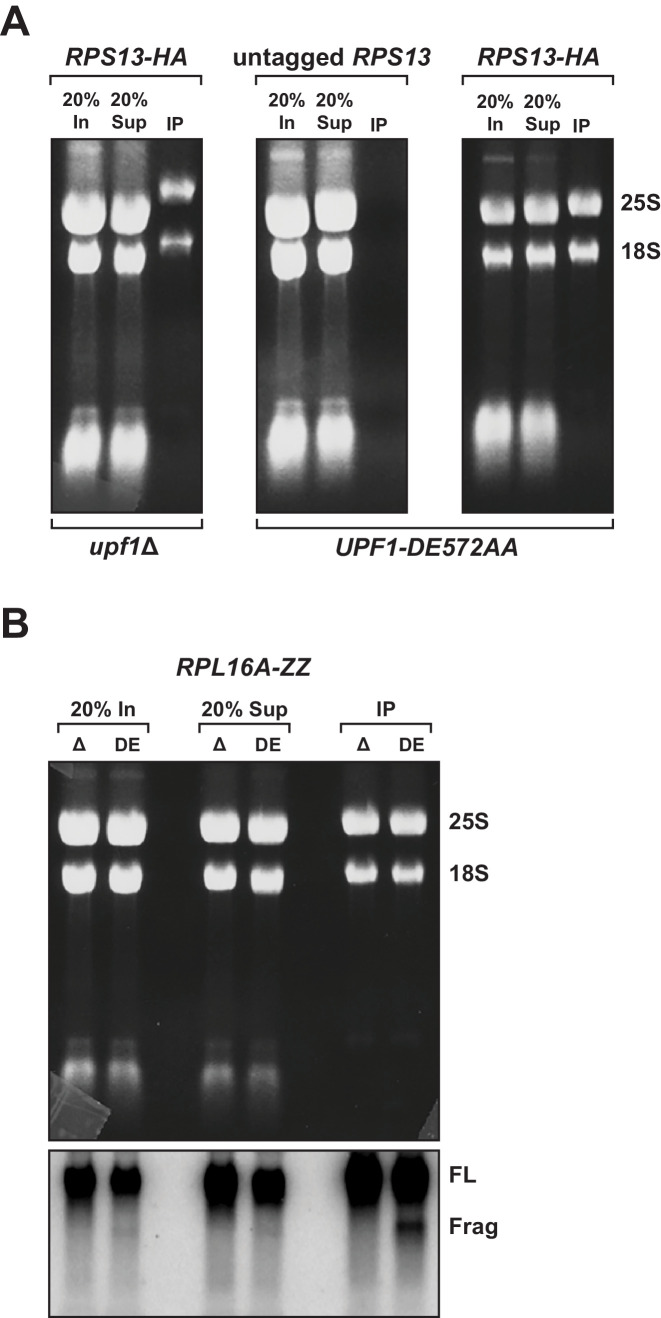
3’ RNA decay intermediates are ribosome bound.(A) Agarose gel electrophoresis and ethidium bromide staining of material co-immunopurified with untagged or epitope-tagged RPS13 (RPS13-HA) in cells deleted for UPF1 (upf1∆) or expressing the ATPase-deficient mutant, UPF1-DE572AA. Samples include input (In), supernatant (Sup) and immunopurified (IP) material; presence of 18S and 25S ribosomal RNA indicated. (B) Agarose gel electrophoresis and ethidium bromide staining (top) and northern blot analysis of GFPPTC125 mRNA (bottom) on material co-immunopurified with epitope-tagged RPL16 (RPL16-ZZ) in cells deleted for UPF1 (∆) or expressing the ATPase-deficient mutant (DE). Full-length mRNA (FL) and 3’ decay fragments (Frag) indicated.